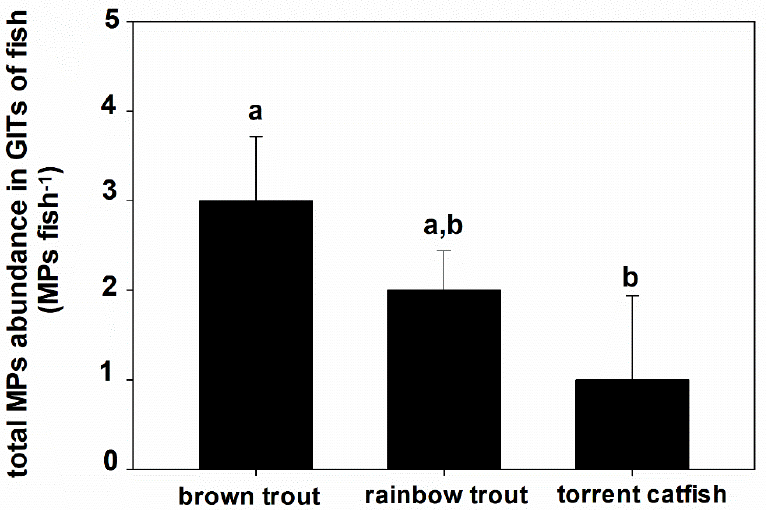
Figure 2. Total MPs abundance in fish GITs from Mendoza River in the Central Andes range. Bars represent medians and the whiskers standard errors. Different lower-case letters indicate significant differences in the fiber content among fish species (Kruskal – Wallis H test (KW), followed by a posteriori multiple comparisons of mean ranks for all groups).